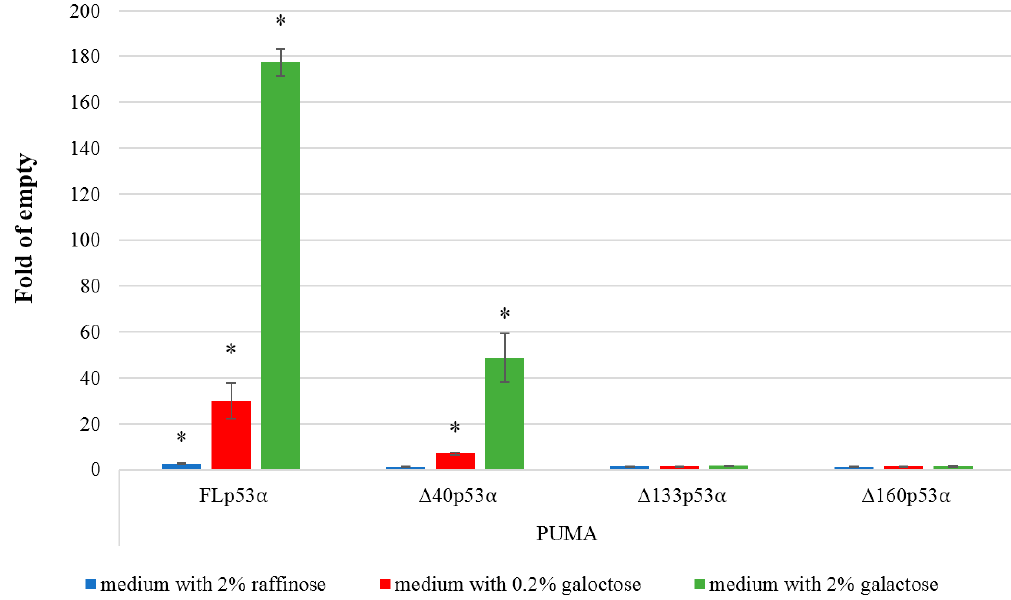
Figure 3. p53-dependent transactivation potential in yeast. All p53 α isoforms are expressed under an inducible GAL1 promoter. Histograms show the average fold induction over empty vector in three biological replicates (mean ± S.D.). The results with three levels of p53 induction (no induction, moderate, high) obtained after 24 h in inducing media are presented. Asterisks indicate a significant induction of p53 dependent transactivation ( p < 0.05).